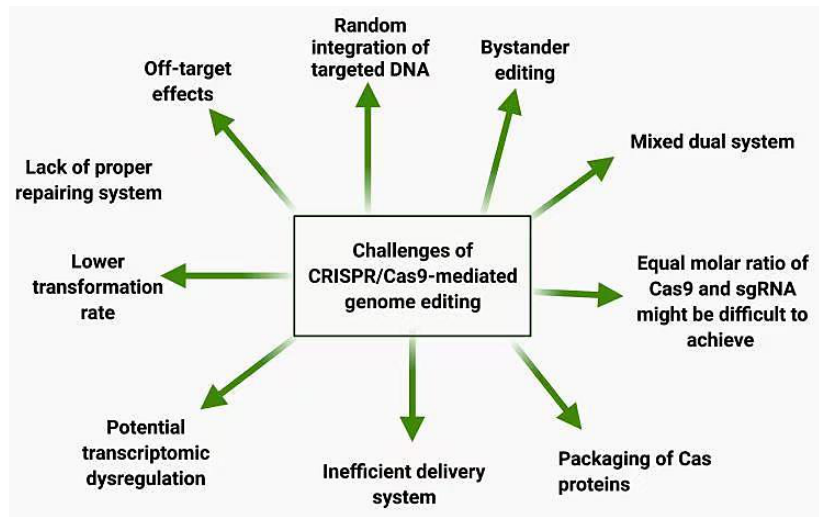
Figure 5. Challenges of CRISPR/Cas9 gene editing. Cas9 has low efficiency of transformation methods, lack of efficiency of the delivery system, and difficultyin achieving an equal molar ratio of Cas9 and sgRNA. These challenges hinder its use for further crops improvement on a larger